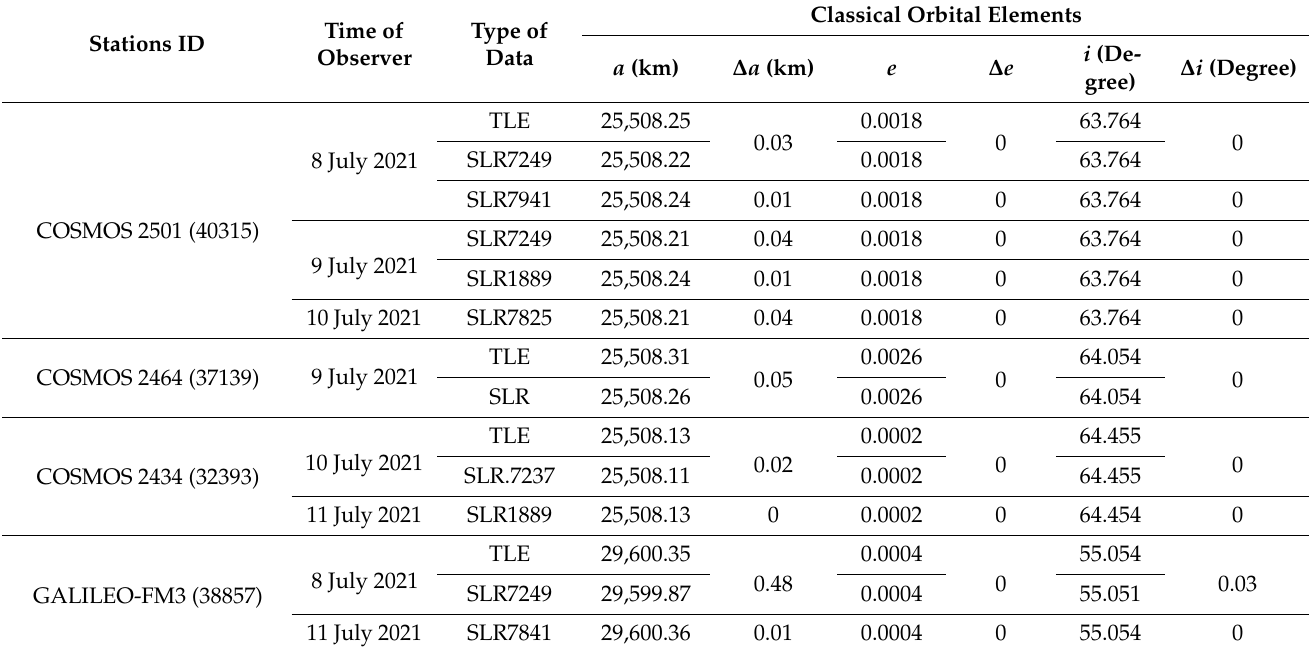
Table 6. SLR observation parameters.